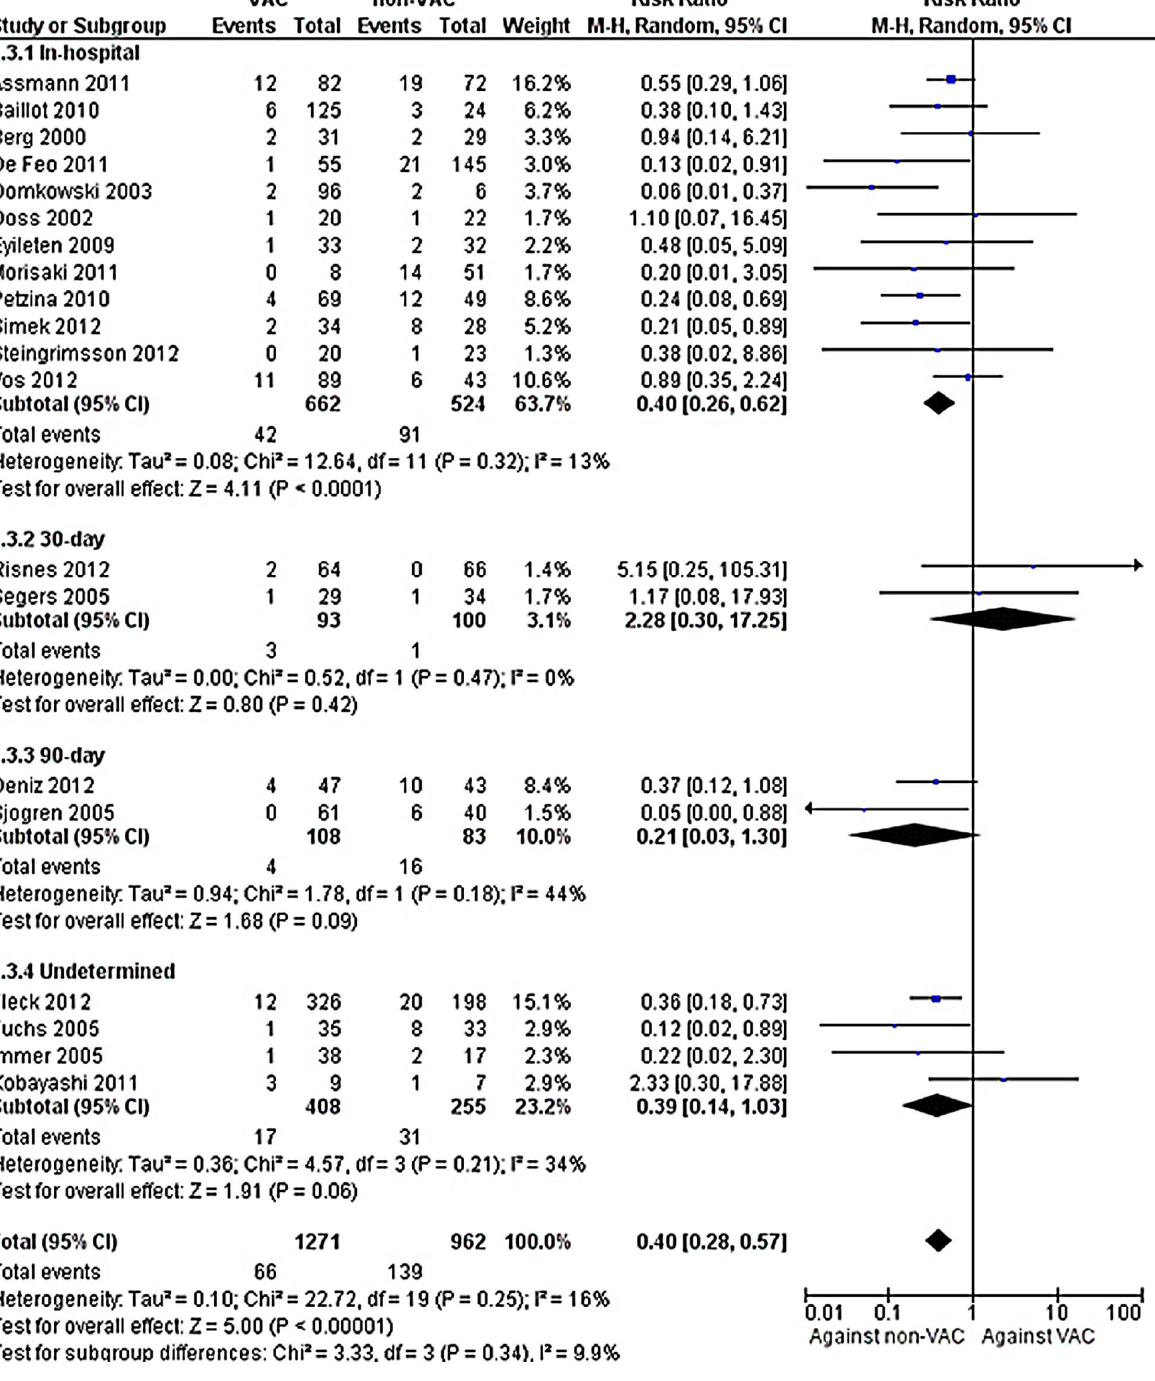
Figure 3. Forest plot depicting the risk ratios (RR) of mortality of patients according to the time of mortality assessment. ( Vertical line="no difference" point between the two regimens. Squares=risk ratios; Diamonds=pooled risk ratios for all studies. Horizontal lines=95% CI ).